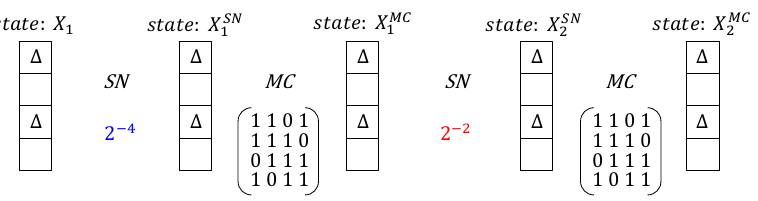
Figure 9: Analysis of simple case (∆ = 0x4 ). Probability is 2 − 8 if two SN operations are evaluated independently, while the exact probability is 2 − 6